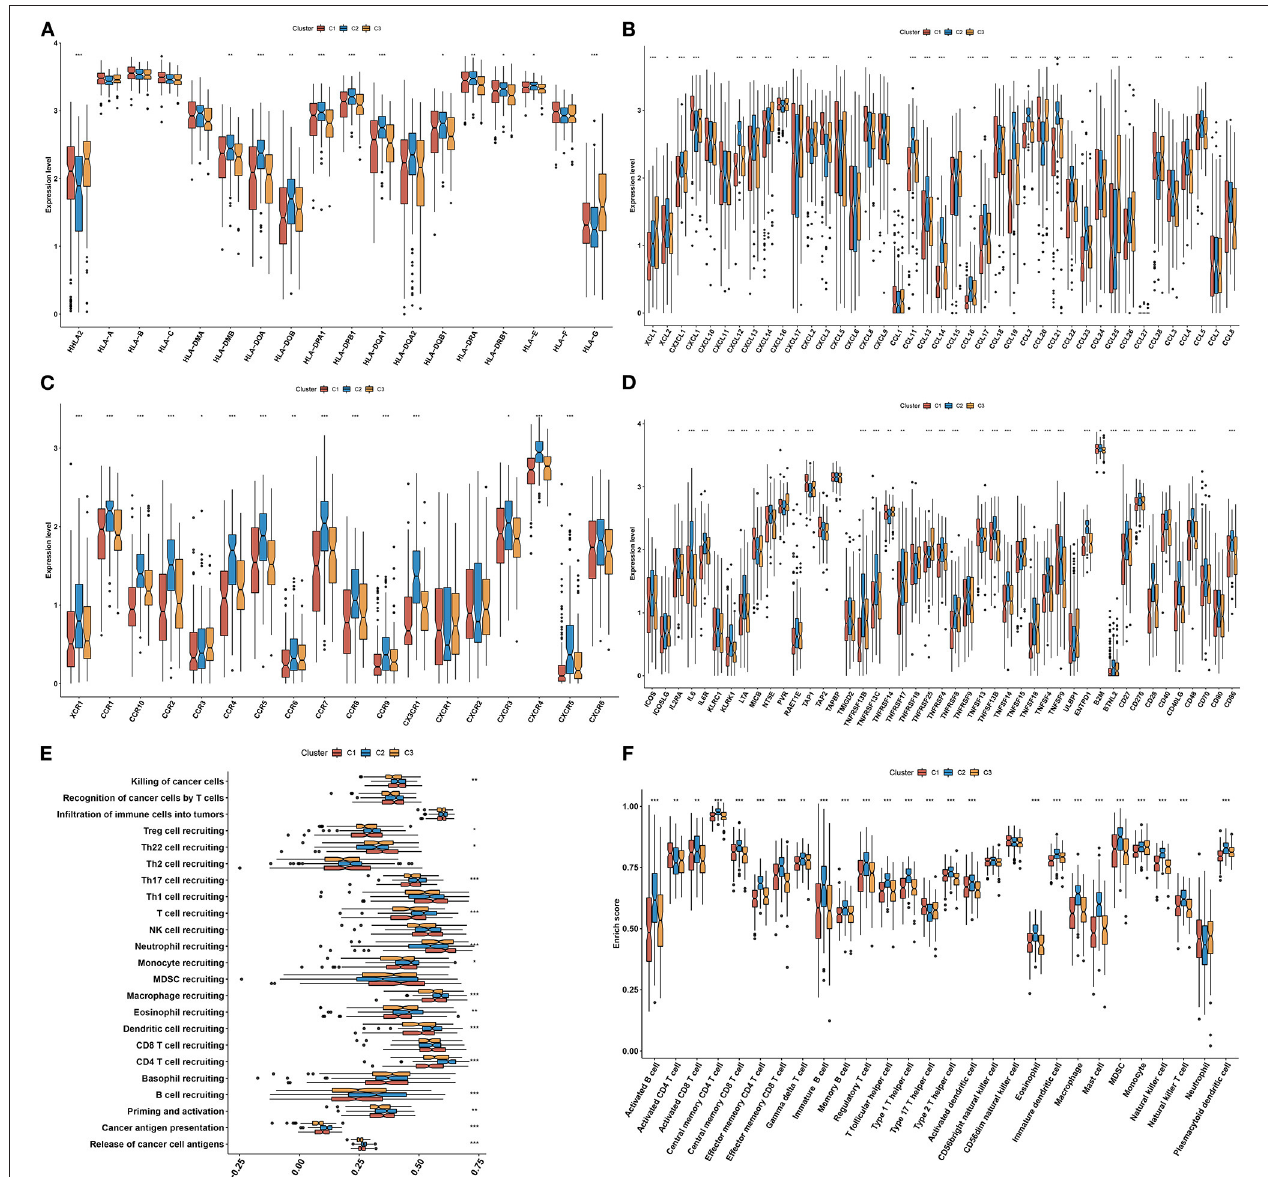
FIGURE 4 | Three aging-associated molecular phenotypes display diverse tumor immune microenvironment and immunogenomic characteristics. (A–D) Comparisons of the mRNA expressions of immunomodulators, including (A) MHC, (B) chemokines, (C) receptors, and (D) immune checkpoint molecules among three aging-associated molecular phenotypes. (E) Comparisons of the activities of all steps in the cancer immunity cycle among three molecular phenotypes. (F) Comparisons of the infiltration levels of tumor-infiltrating lymphocytes among three molecular phenotypes. * p < 0.05; ** p < 0.01; *** p < 0.001.